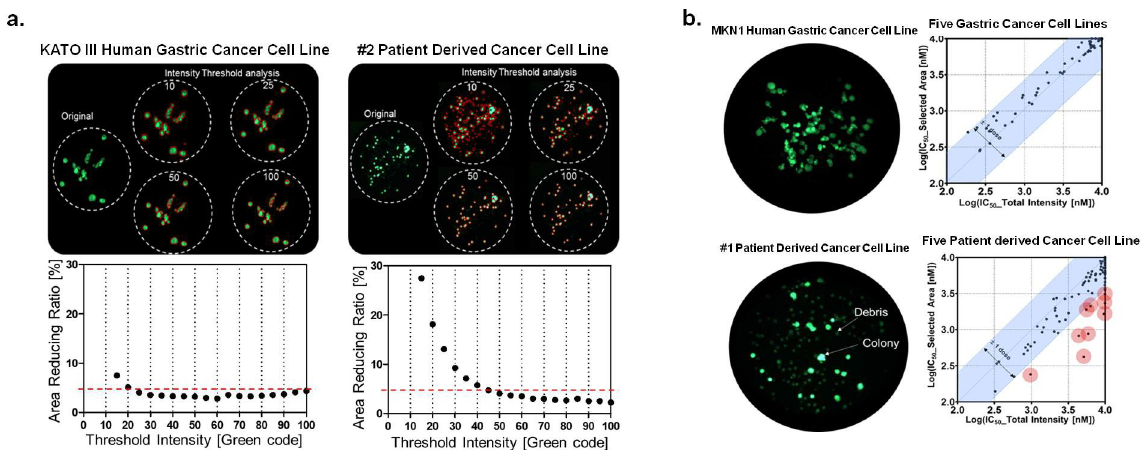
Fig 2. (a) Cell images and area reducing ratio of KATO III human gastric cancer cell line and #2 patient-derived cancer cell line (PDC) according to intensity thresholds. Red mark in the images are the selected colonies according to intensity thresholds. (b) Colony images and IC 50 values comparison between MKN1 human gastric cancer cell line and #1 PDC. Contrary to MKN1 gastric cancer cell line image, colony formation was seen only with some of the cells from the #1 PDC. In the five PDCs, IC 50 values calculated by the selected area were generally lower than those calculated using total intensity. Ten outliers (red circles) who IC 50 difference between total intensity and selected area analysis is more than 1 dose (3 times) were observed.